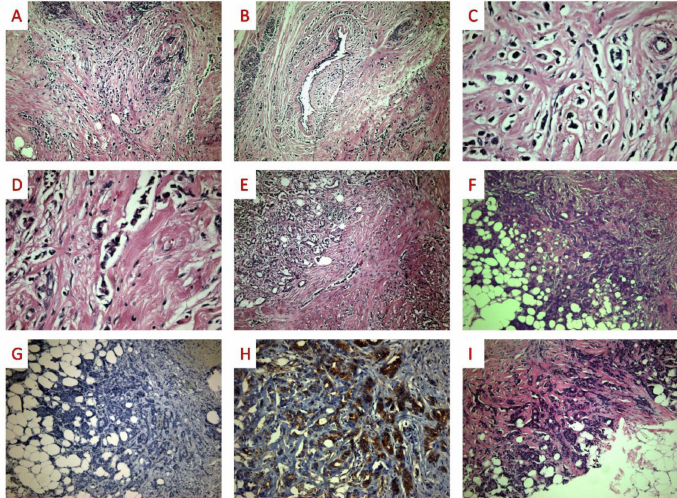
Figure 3. ILC with tubular elements (( A , B ) 100 × ): Areas of conventional growth pattern consisting of single-cell files. (( C , D ) 200 × ): On higher power examination, tumor cells are characterized by a lack of cohesion. (( E , F ) 40 × ): Adjacent to the single-cell files, several tubular elements can be seen. (( G ) E-cadherin 40): On immunohistochemistry, the tubular elements lack E-cadherin staining (( H ) β -catenin 40 × ), but retain β -catenin expression (( I ) 40 × ): This ILC variant may be misdiagnosed as well as differentiated NST or as tubular carcinoma, especially in a biopsy specimen consisting only of tubular